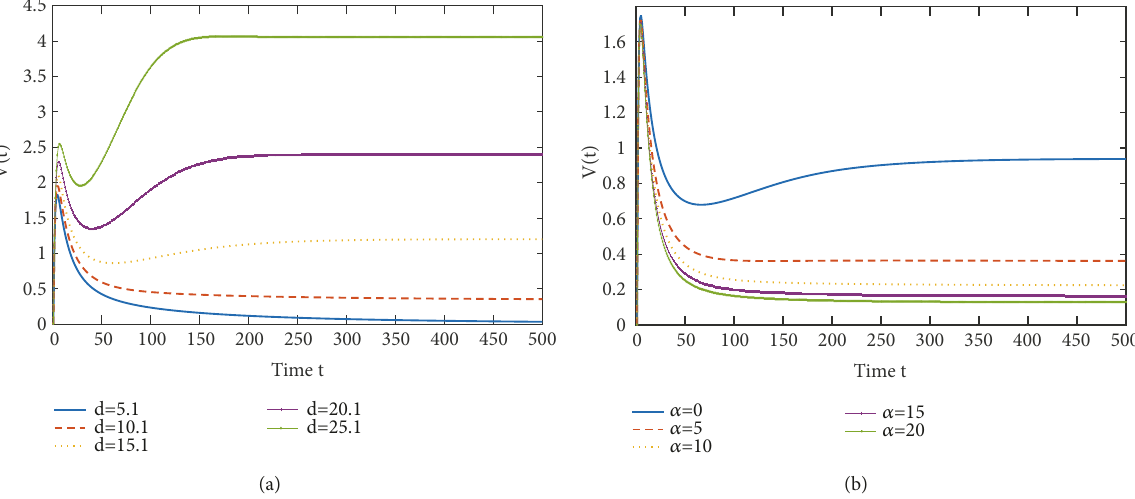
Figure 2: The evolution of the cumulative density of free viruses with parameters as those for Figure 1 except 𝑑 and 𝛼 . (a) 𝑑 ∈ [5.1 : 5 : 25.1] and 𝛼 = 0.5 ; (b) 𝛼 ∈ [0 : 5 : 20] and 𝑑 = 10 −5